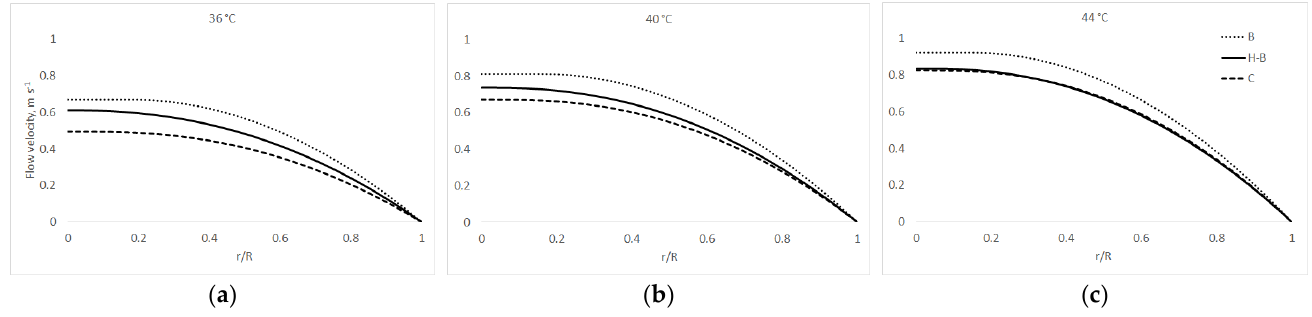
Figure 1. EDC velocity profiles: at ( a ) 36 °C; at ( b ) 40 °C; and at ( c ) 44 °C. Figure 1 models the EDC sample flow velocity using all three rheology models (1)–(3) and Equations (6)–(8) used above at temperatures of 36, 40, and 44 ◦ C. Figure 2 models the flow velocity of the MC sample using the Herschel–Bulkley model (Equation (2)) coefficients and Equation (8). The figure shows the temperature dependence of this chocolate mass, when the mass flows the fastest and vice versa at the highest temperature (44 ◦ C)